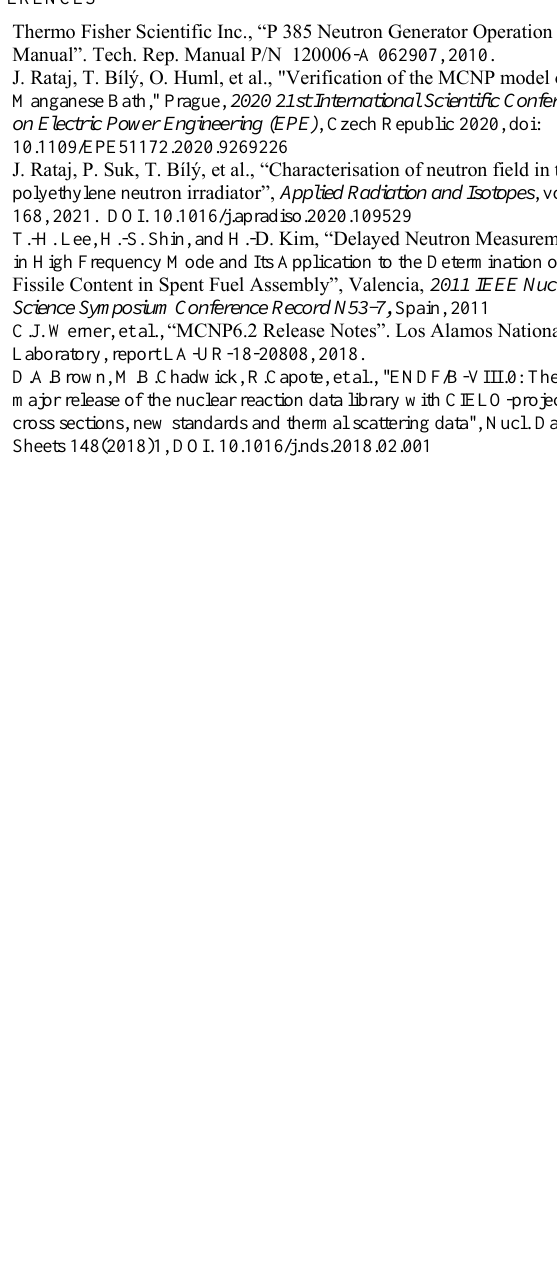
Fig. 11 Cadmium-covered detector response to P-385 D-D neutron generator operated at 130 kV and 70 µA for pulsed operation at 100 Hz and 250 Hz with duty factor ranging from 10 % to 50 %.